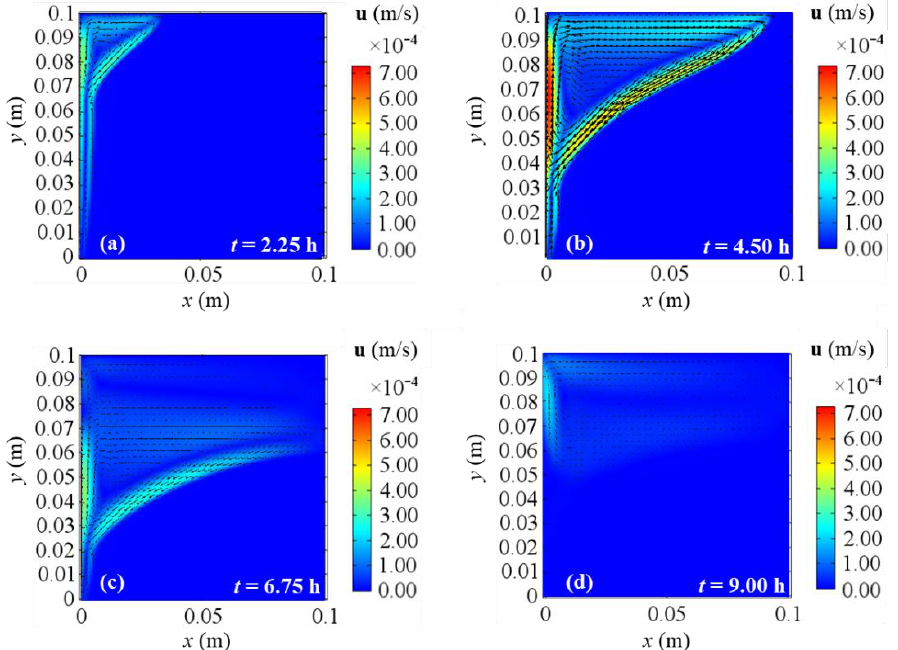
Figure 12. Velocity fields for 2D model with natural convection and BC 3 at different evaluation times: ( a ) after 2.25 h; ( b ) after 4.50 h; ( c ) after 6.75 h; ( d ) after 9.00 h from the simulation beginning respectively.